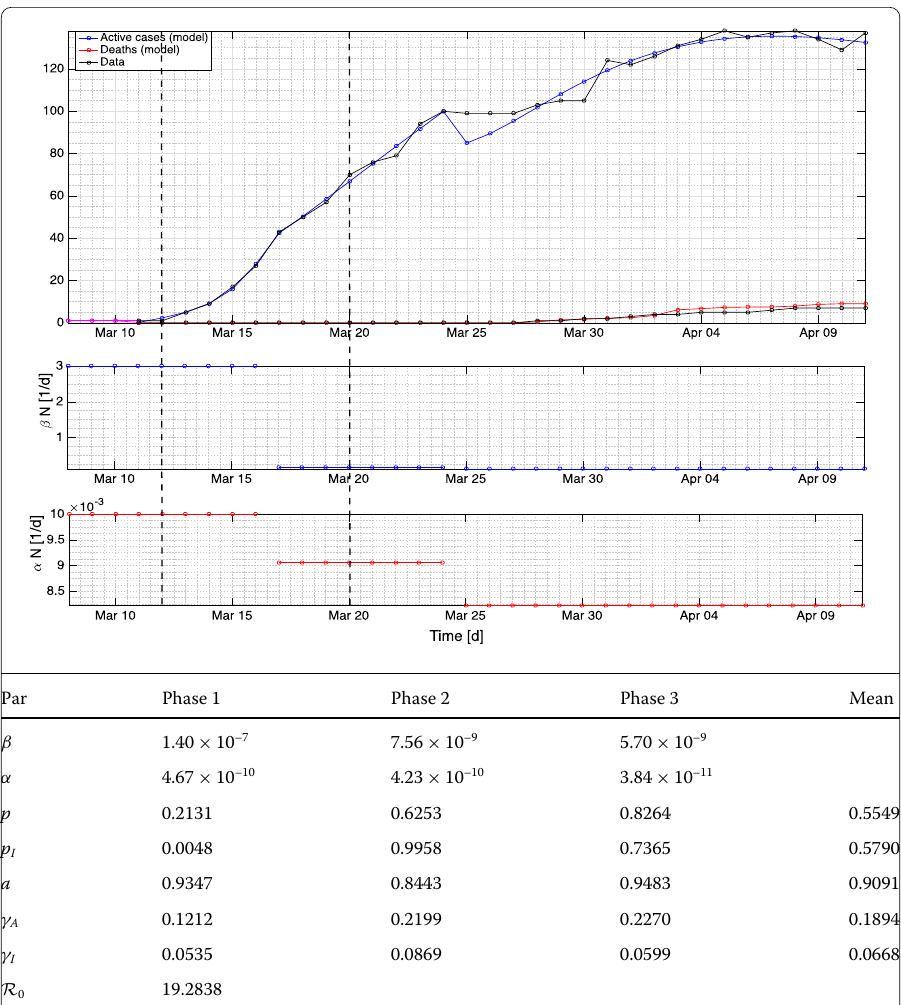
Figure 3 Fitting results using data for Sri Lanka. Vertical dashed lines encode the commencements of school closure and public curfew, respectively